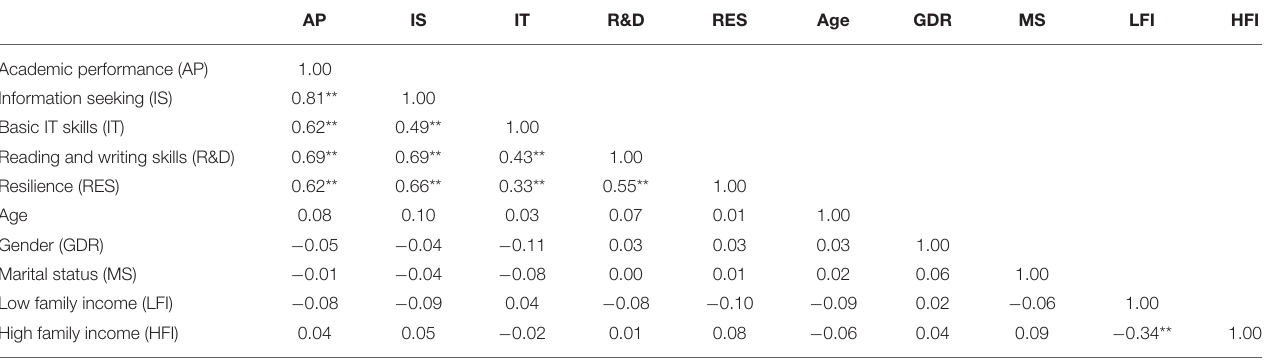
TABLE 3 | Correlation among pairs of variables. AP IS IT R&D RES Age GDR MS LFI HFI